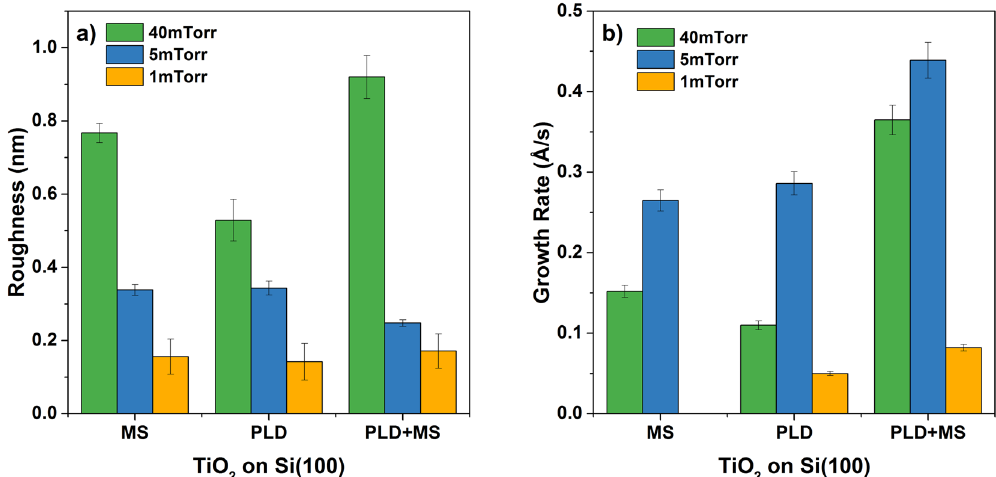
Figure 3. Morphological parameters of thin films. ( a ) AFM-measured roughness of 5 μ m × 5 μ m TiO 2 films as a function of argon pressure. ( b ) Growth rate of TiO 2 films at different values of